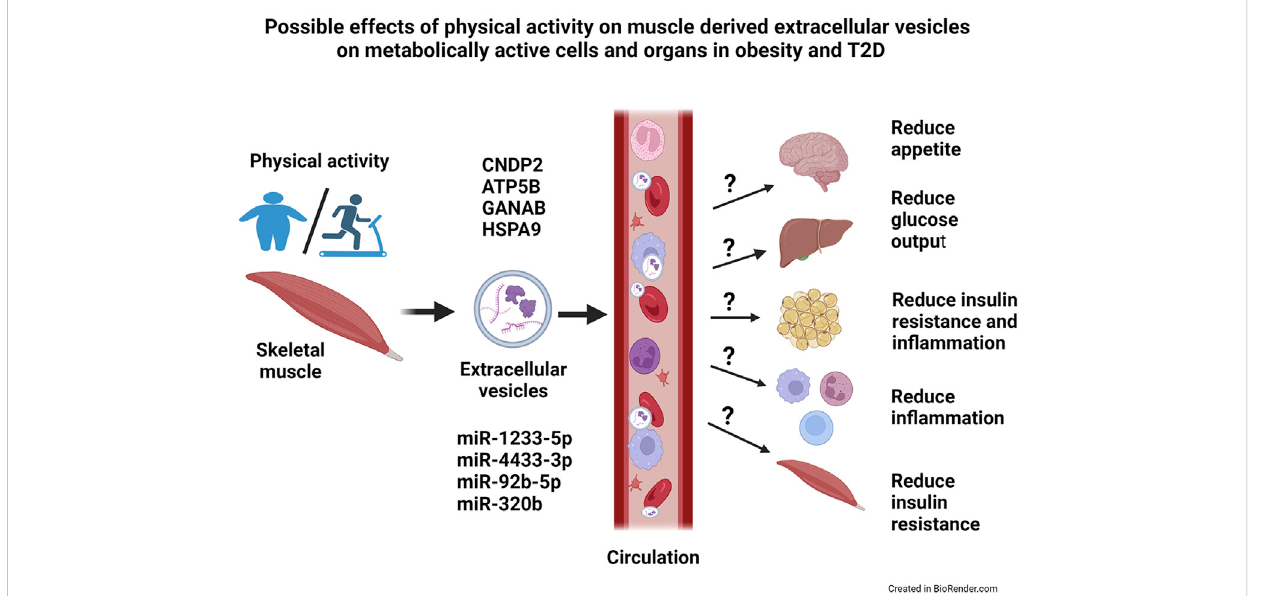
Possible effects of physical activity on skeletal muscle-derived extracellular vesicles on metabolically active cells and organs in obesity and type 2 diabetes (T2D). Skeletal muscles release extracellular vesicles (EVs) in response to exercise, and most likely will these EVs circulate and reach target organs. The EVs contain bioactive molecules, both microRNAs (miRs) and proteins, that might have a regulatory role on the metabolically active target cells and organs. Possibly, will EVs contribute to the health effects of exercise by reducing appetite, improve insulin sensitivity and reduce the